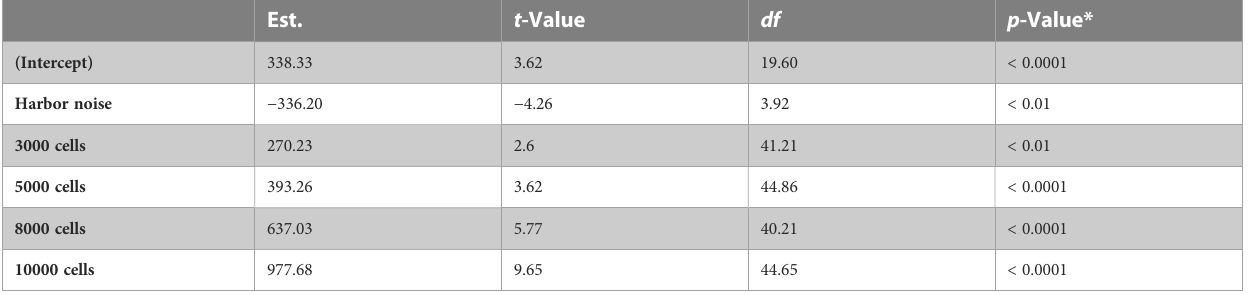
TABLE 5 Final optimal model summary of estimated noise treatment and prey density effects on copepod ingestion rates.